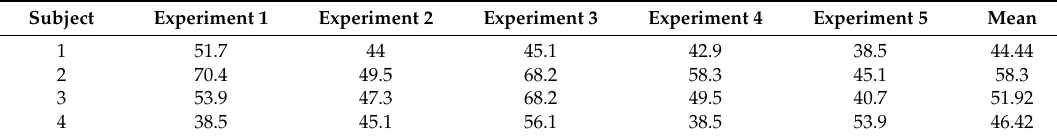
Table 8. Execution time for different subjects conducting different trials of a maze